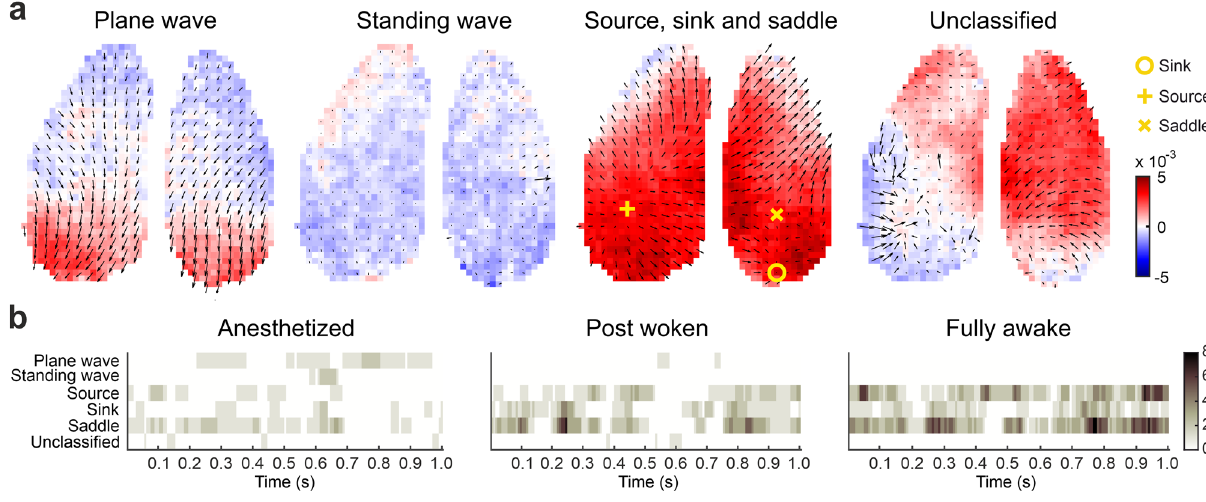
Fig.4|Classi fi cationanddetectionofspeci fi cwavepatternsatthecortex-wide scale. a Examples of wave patterns: plane wave, standing wave, source, sink and saddle. The background color represents the voltage amplitude. b Time course of